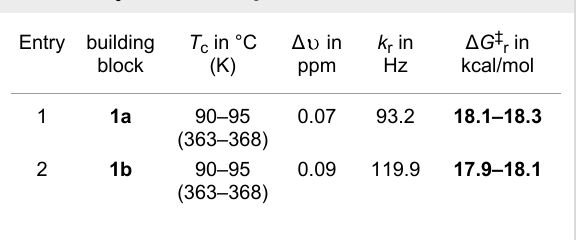
Table 3: Δ G ‡ c values of building blocks 1a , b